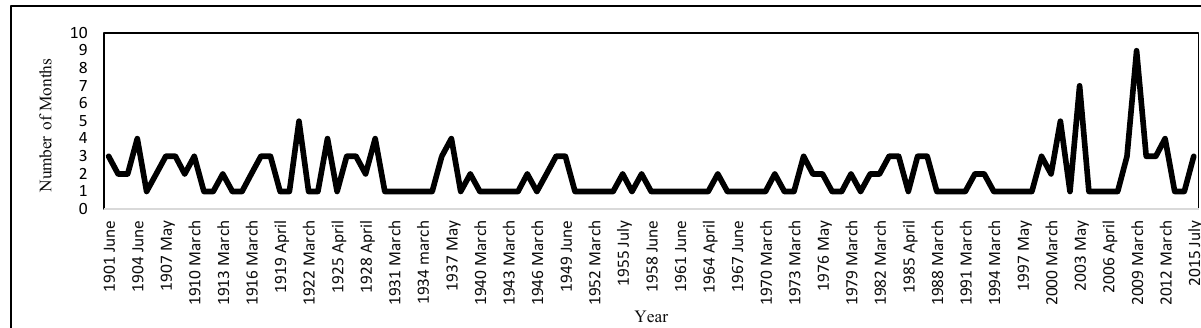
Figure 5.Graph showing persistence of drought in grid 164 (18.83N, 76.108E)